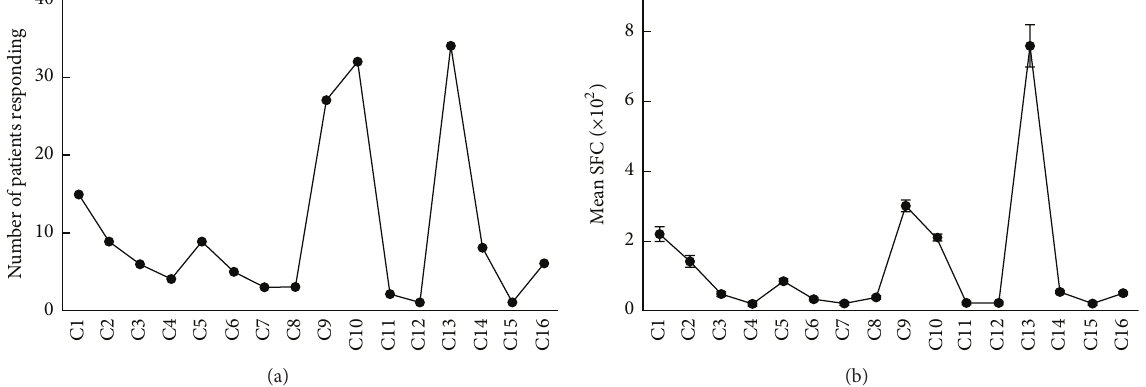
Figure 3: Antigenic regions from CFP-10. PBMCs were incubated with overlapping peptides from CFP-10 (C1–C16), and the number of IFN- 𝛾 producing cells was measured using the ELISPOT assay. Shown are numbers of donors who responded (a) and the mean ( ± SE) number of SFCs (spot forming cells)/10 7 PBMCs in response to each peptide